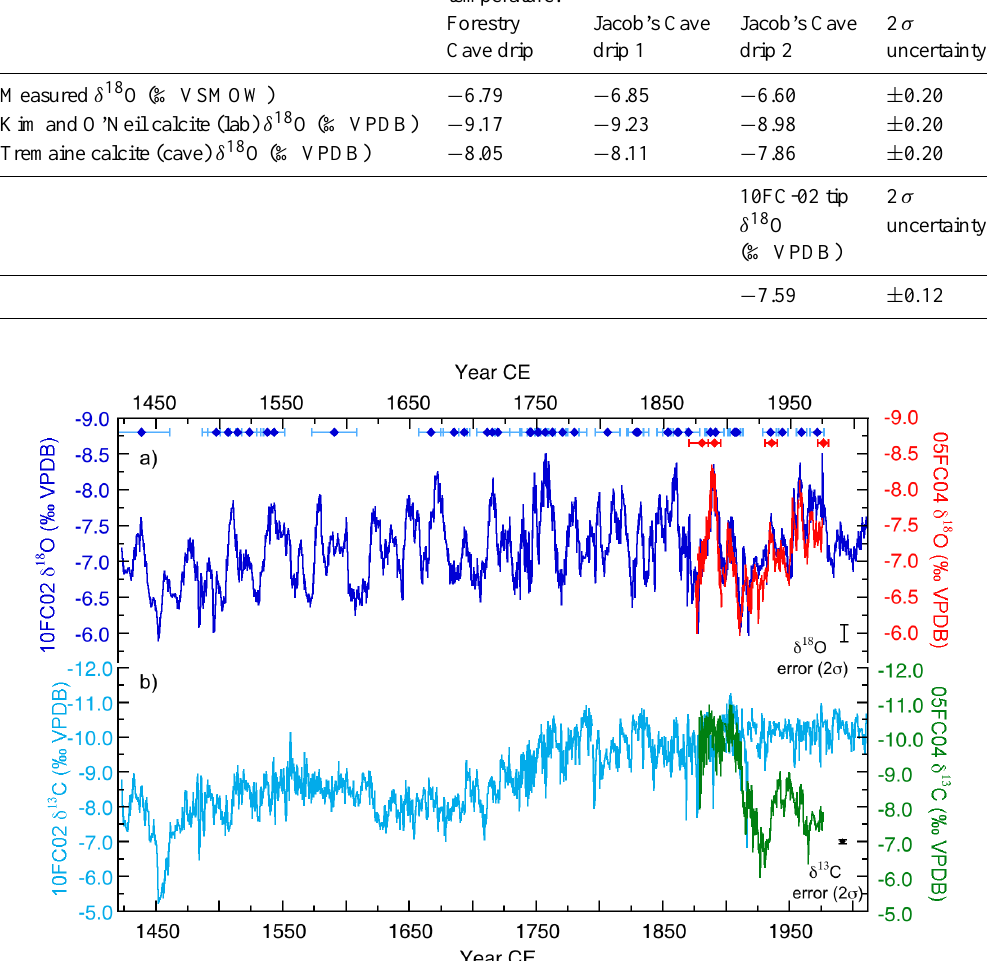
Figure 5. Stable oxygen isotopic variations in Guadalcanal stalagmites 10FC-02 and 05FC-04. Blue (red) diamonds with ± 2 σ error bars illustrate the locations of 10FC-02 (05FC-04) U–Th ages; black circles with ± 2 σ errors denote uncertainties for stable isotopic measure- ments. There is strong reproducibility in the δ 18 O in the two stalagmites (panel a), in contrast to the limited reproducibility in the δ 13 C records (panel b). There is a weak correlation ( R 2 = 0 . 11, p < 0 . 01) between the oxygen and carbon isotope records in the 10FC-02 stalag- mite. The chronology of the 05FC-04 stalagmite record has been adjusted by ∼ 5 years to maximize the goodness of fit between the δ 18 O records. This adjustment is less than the ± 6.0-year average uncertainty for the 05FC-02 stalagmite U–Th